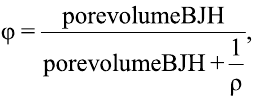
The porosity φ of the samples was calculated from BJH data via Equation